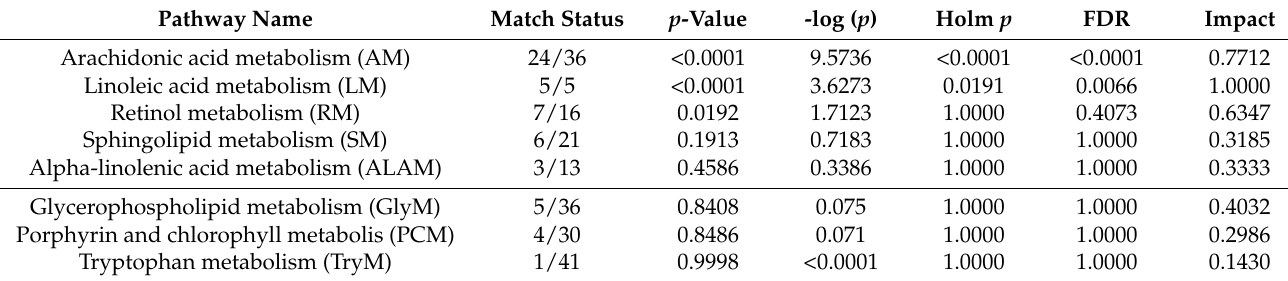
Figure 5. The representative base peak intensity (BPI) chromatograms in ESI+ and ESI– modes.